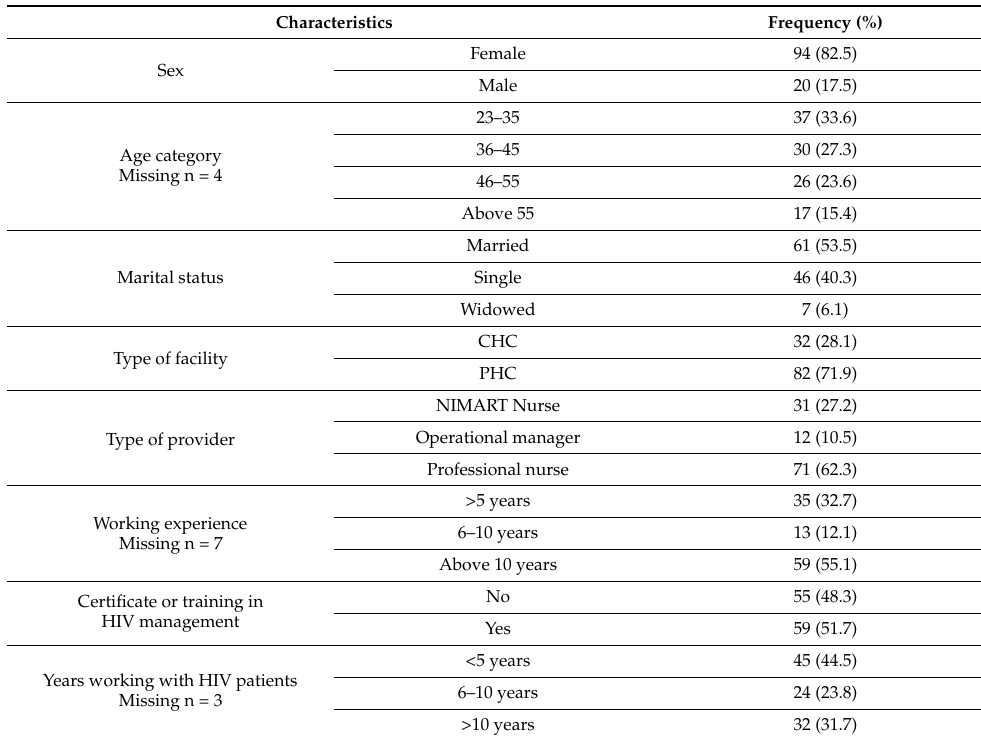
Table 1. Profile of the respondents in the study.